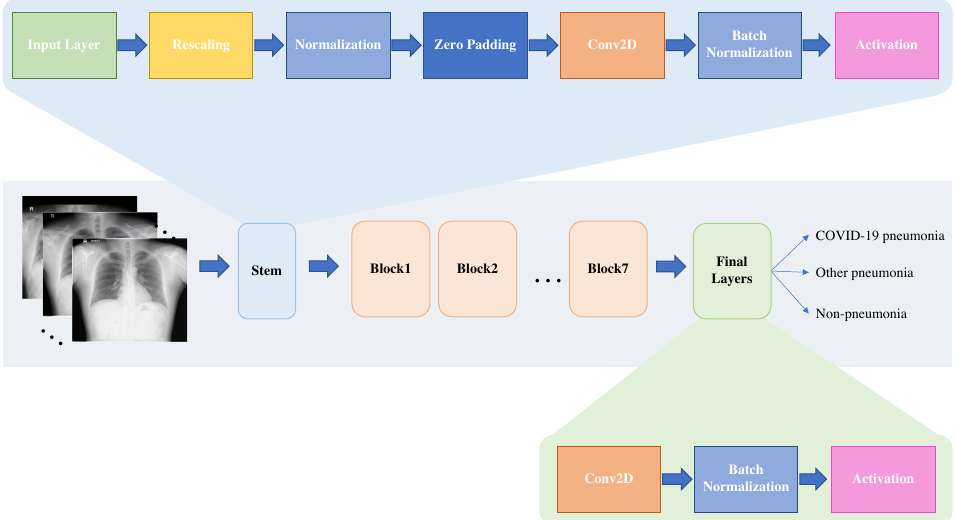
Figure 2. The architecture of EffcientNet-b7 for CXRs classification. The model takes CXRs as inputs and ultimately classifies them into three categories: non-pneumonia, non-COVID-19 pneumonia, and COVID-19